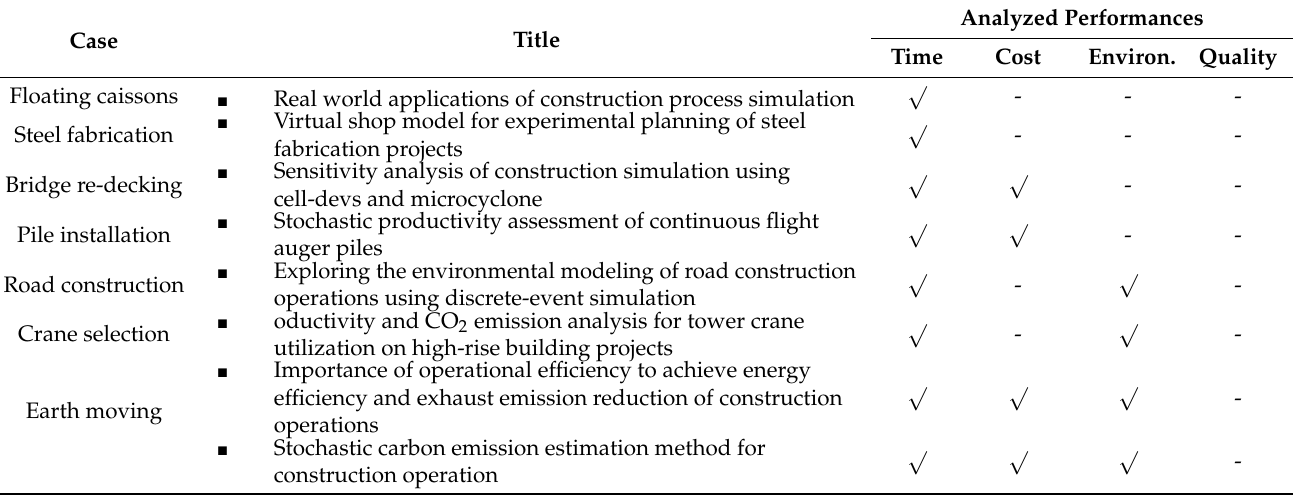
Table 3. Application cases and analyzed performance